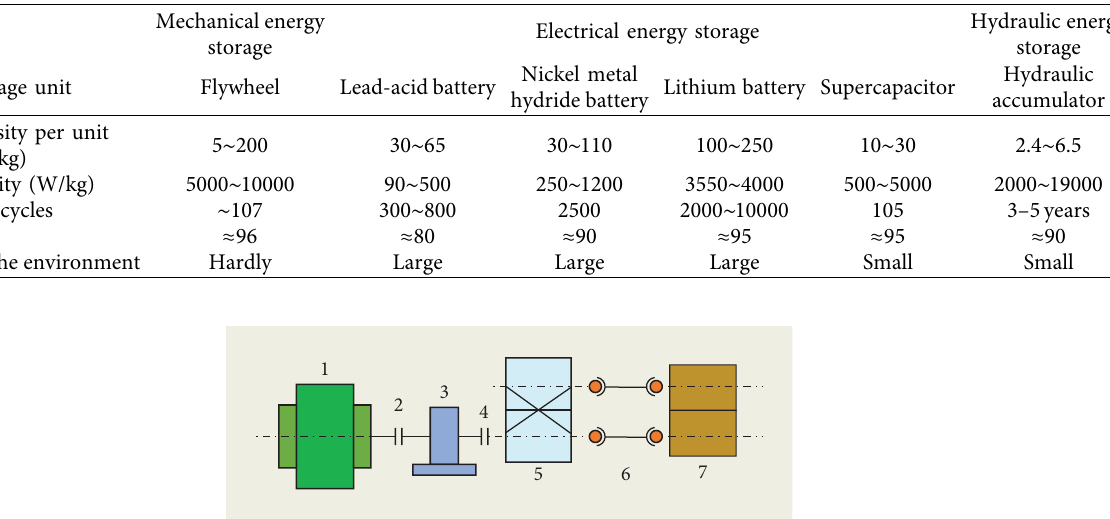
Figure 1: Structure of primary drive device of general rolling mills: (1) main motor; (2) motor coupling; (3) reducer; (4) main coupling; (5) gear seat; (6) universal joint shaft; (7) rolls.